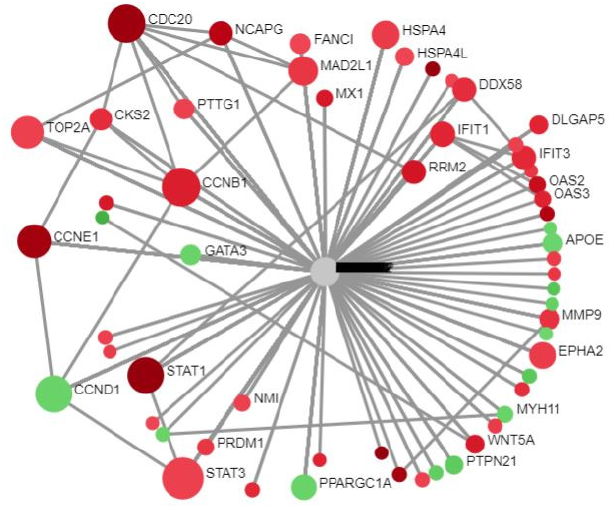
Figure 1. Circular bipartite view of SN1.